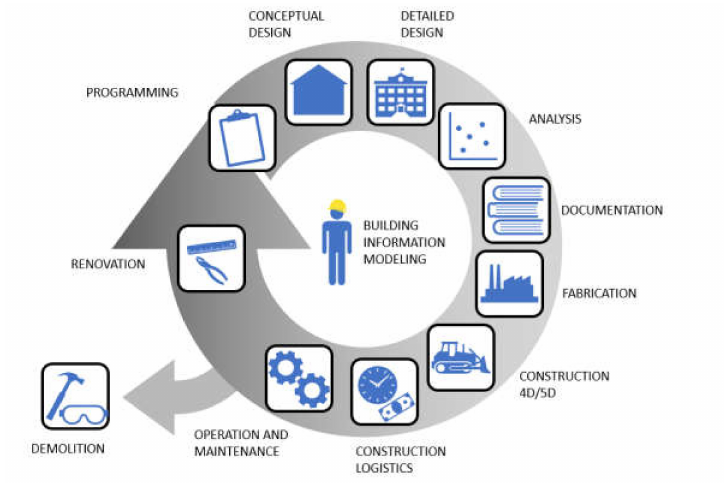
Figure 1. Building information modelling (BIM) applications across buildings’